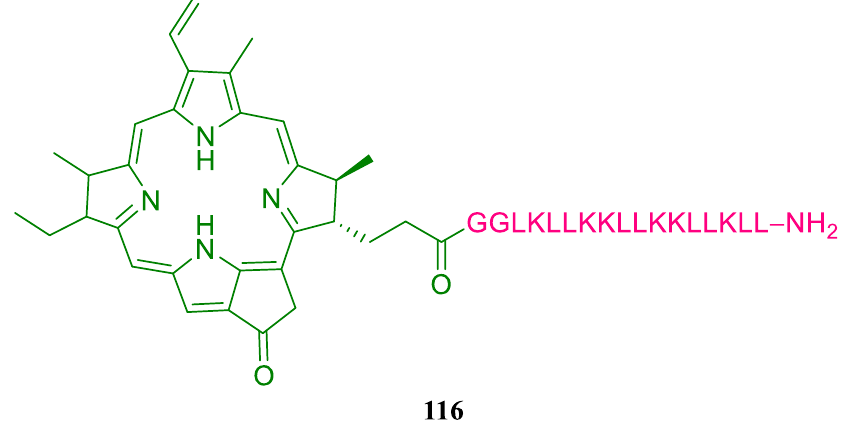
Figure 95. PPA conjugated to antimicrobial peptide.